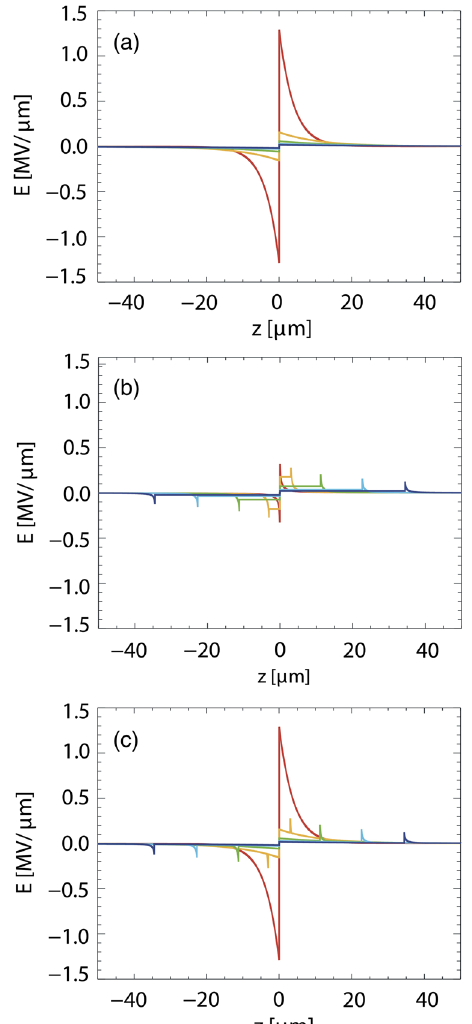
FIG. 7. Spatial distribution of the normal electric field compo- nent E N ð r ¼ 0 ; z; t Þ in the z-direction at different times (red: 0 ps, orange: 0.5 ps, green: 1 ps, light blue: 1.5 ps, dark blue: 2 ps. For the field calculations the parameters of Tables I and II have been used: (a) model A, (b) model B, (c) model